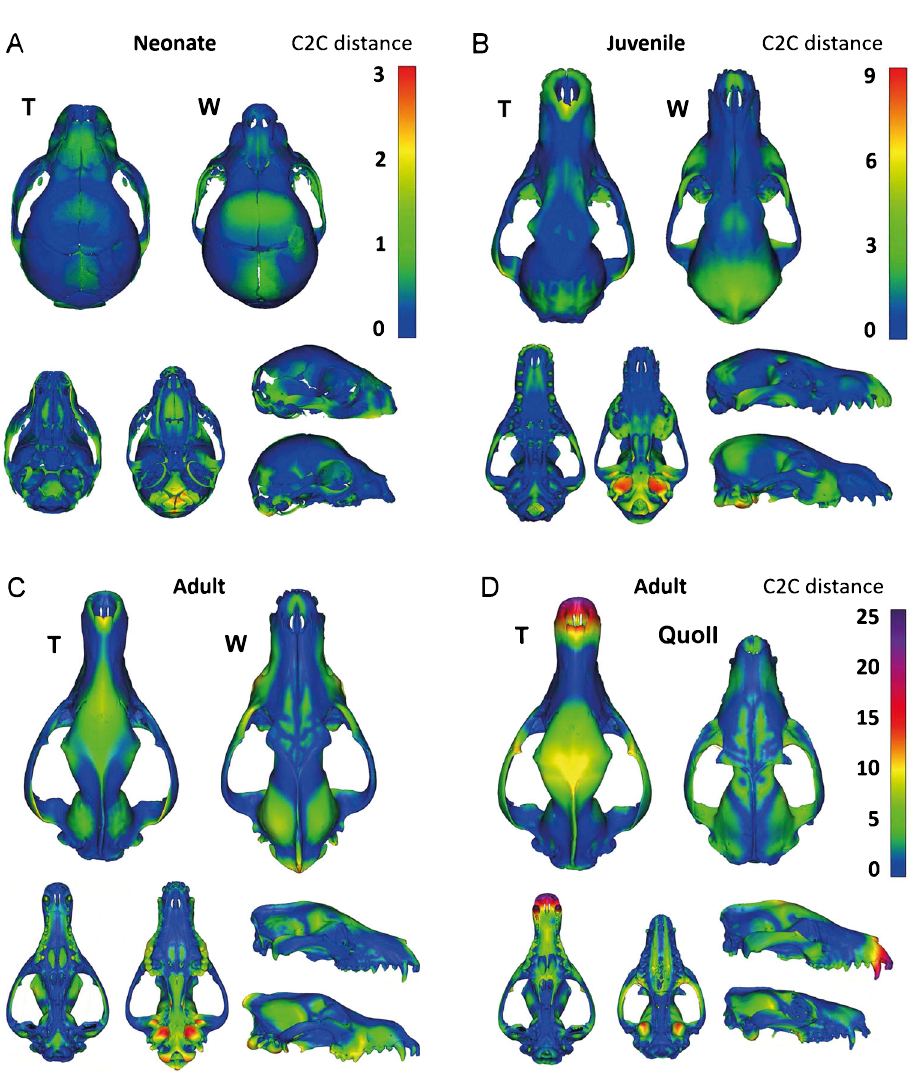
Fig. 3 Point cloud comparisons of thylacine and wolf ontogenetic cranial shape. Small point-to-point differences are expressed as cool colors (blue/green) while large differences are observed as warm colors (red/purple). Warmer colors denote greater Euclidean distances between point clouds. Minor shape differences are observed between thylacine (T) and wolf (W) crania at A neonatal, B juvenile, and C adult stages. Similarities become apparent when the thylacine is compared with its extant relative, d the Eastern quoll.